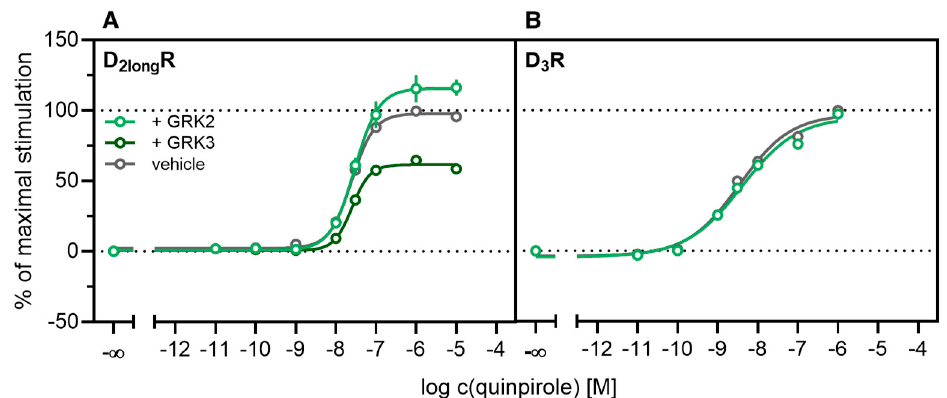
Figure 7. Influence of exogenous GRK2 or GRK3 overexpression on β -arrestin2 recruitment. HEK293T cells stably co-expressing ELucN- β arr2 and the D x R-ELucC were transiently transfected with GRK2 / GRK3 or empty vector ( A , B ). Data represent means ± SEM from three independent experiments, each performed in triplicate or quadruplicate.